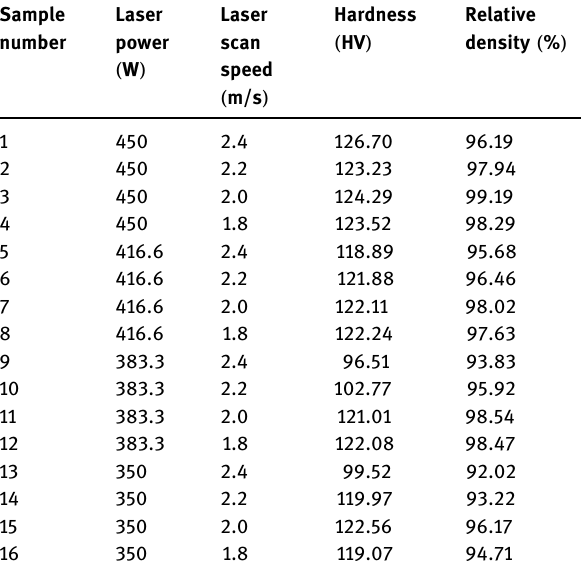
Table 1: Laser parameters, measured hardness, and relative density of CNT - reinforced aluminum matrix nanocomposites fabricated by the LPBF